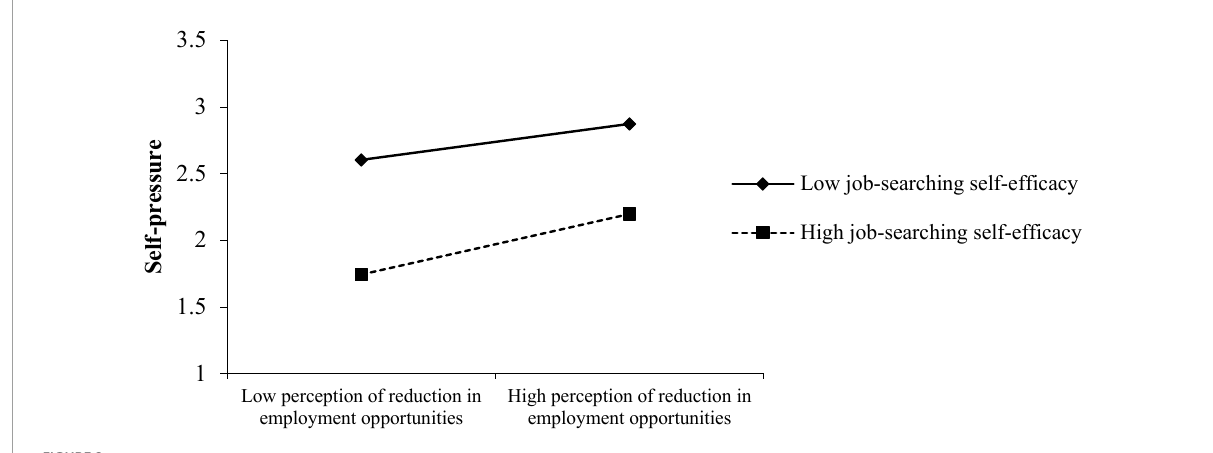
FIGURE2 Role of job-searching self-efficacy in moderating the perception reduction of employment opportunities and college students’